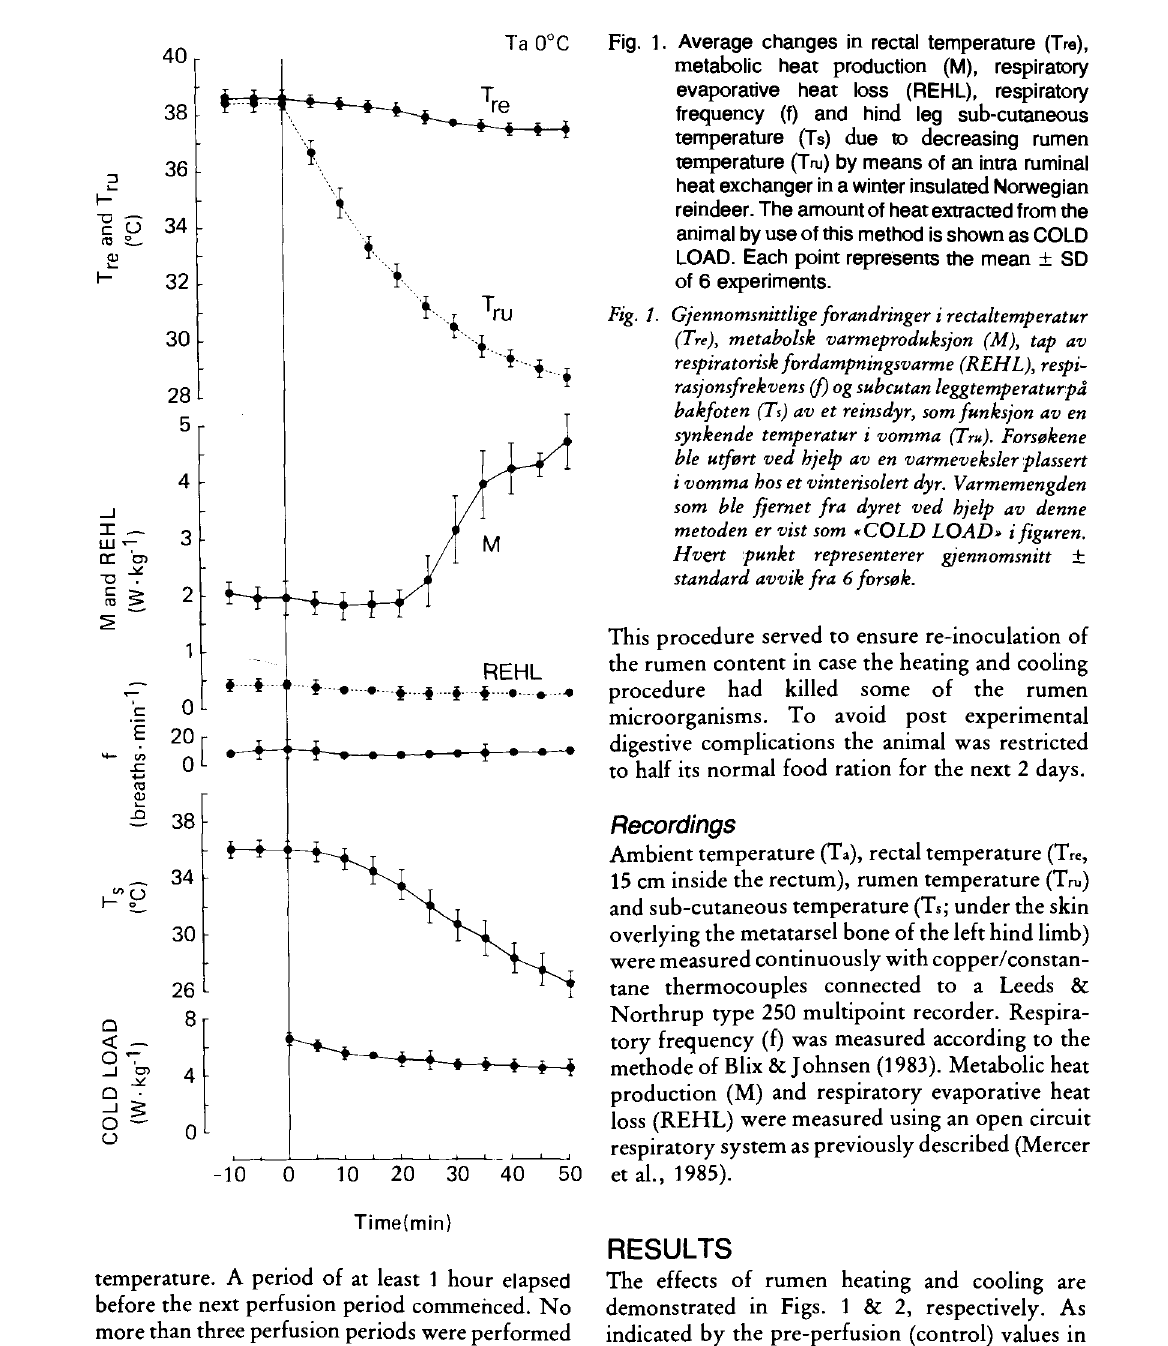
Fig. 1. Average changes in rectal temperature (Tre), metabolic heat production (M), respiratory evaporative heat loss (REHL), respiratory frequency (f) and hind leg sub-cutaneous temperature (Ts) due to decreasing rumen temperature (Tru) by means of an intra ruminal heat exchanger in a winter insulated Norwegian reindeer. The amount of heat extracted from the animal by use of this method is shown as COLD LOAD. Each point represents the mean ± SD of 6 experiments. Fig. 1. Gjennomsnittlige forandringer i rectaltemperatur (Tre), metabolsk varmeproduksjon (M), tap av respiratorisk fordampningsvarme (REHL), respi- rasjonsfrekvens (f) og subcutan leggtemperaturpå bakfoten (Ts) av et reinsdyr, som funksjon av en synkende temperatur i vomma (Tru). Forsøkene ble utført ved hjelp av en varmeveksler plassert i vomma hos et vinterisolert dyr. Varmemengden som ble fjernet fra dyret ved hjelp av denne metoden er vist som «COLD LOAD» i figuren. Hvert punkt representerer gjennomsnitt + standard avvik fra 6